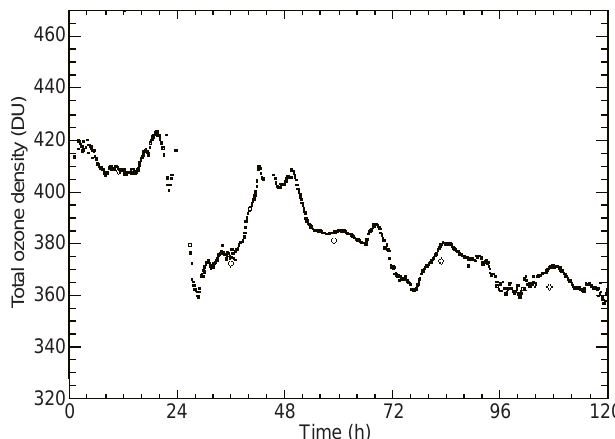
Fig. 4. Ground-based measurements at Ny-A˚ lesund in the period May 17–21, 1997. Diamonds : Dobson measurements; dots : GUV